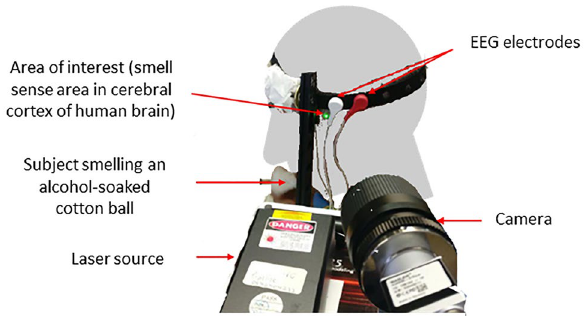
Figure 1. Experimental setup, including laboratory equipment and headset, for synchronized recording of speckle patterns and EEG signal obtained from the cerebral cortex of the human brain. While participating in the data acquisition process the subject smells an alcohol-soaked cotton ball, while the camera EEG are synchronized and are simultaneously recording the